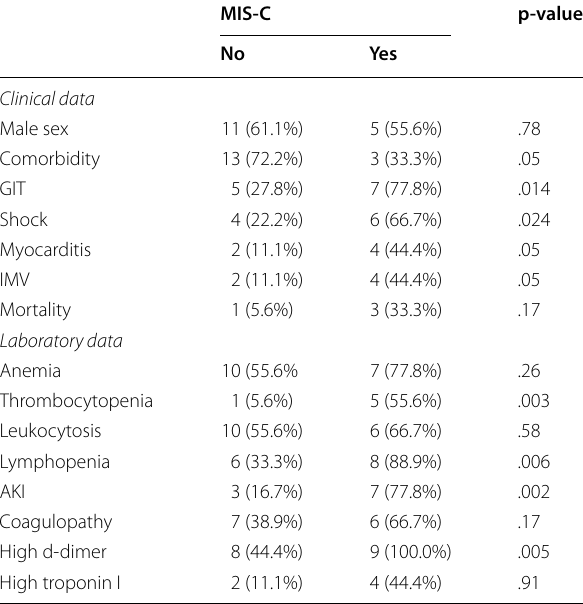
AKI, acute kidney injury; GIT, gastrointestinal tract; IMV, invasive mechanical ventilation; MIS-c, multisystem inflammatory syndrome